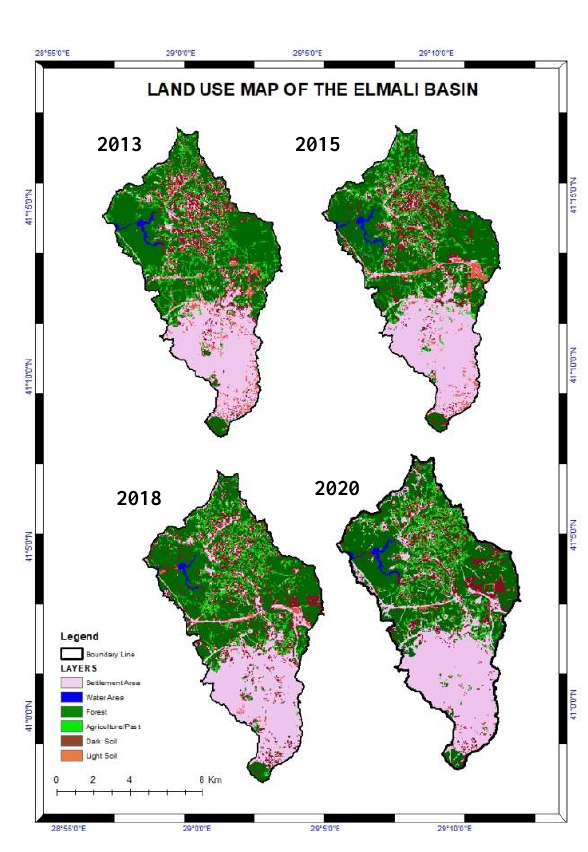
Figure 4. Land Use Maps of Working Years